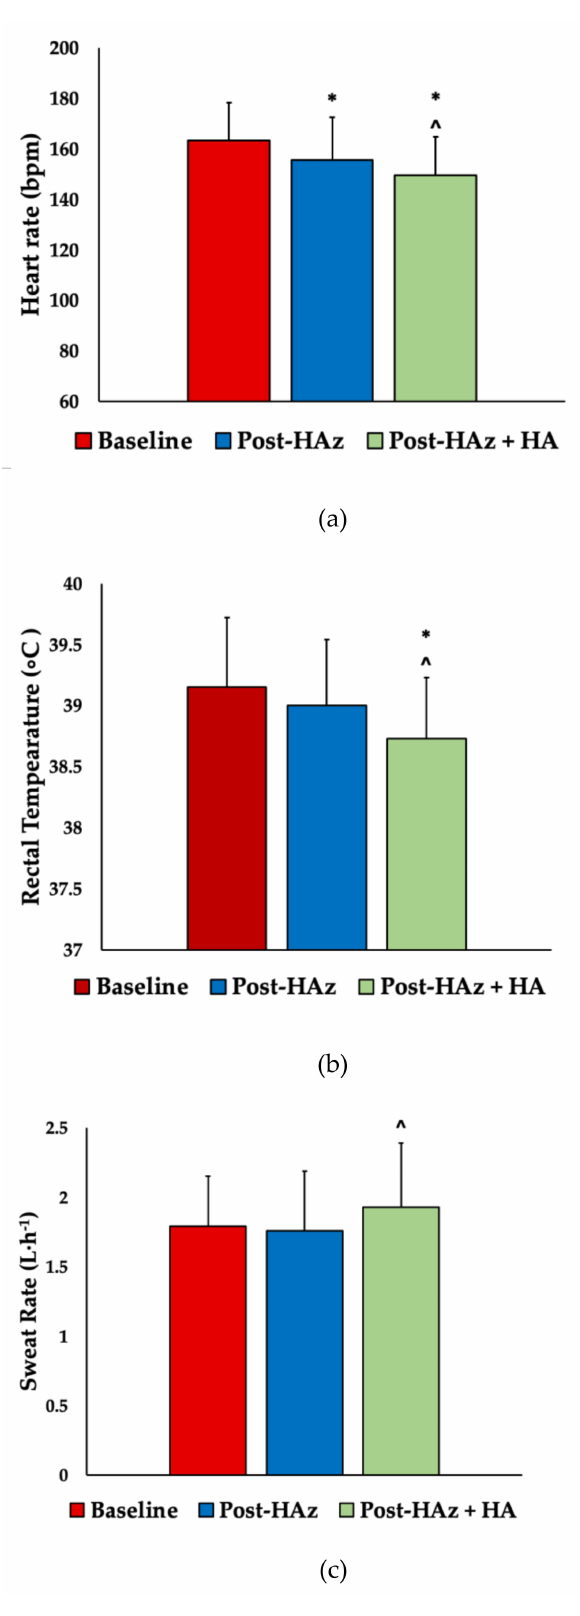
Figure 3. ( a ) Max heart rate, ( b ) max rectal temperature, and ( c ) sweat rate during 60 min of exercise in the heat during baseline, post-heat acclimatization (HAz), and post-heat heat acclimatization plus heat acclimation (HAz + HA). * Indicates statistical differences from baseline, p < 0.05. ˆ Indicates statistical differences from post